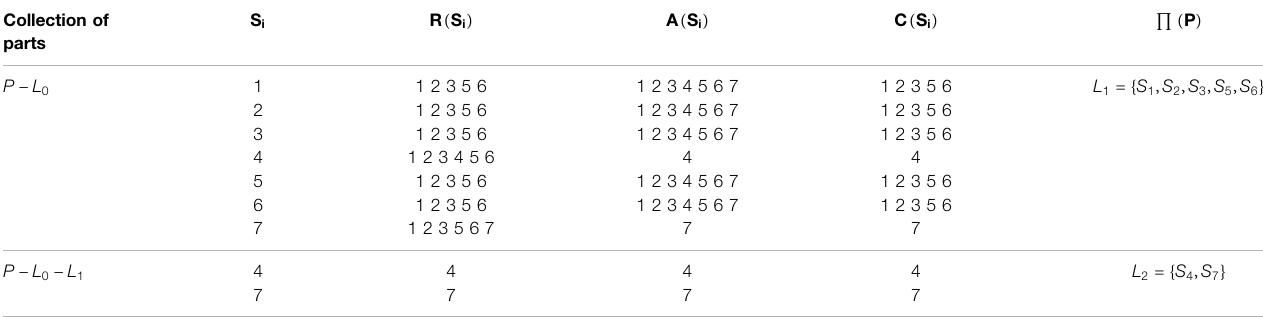
TABLE 1 | Process table of level division.